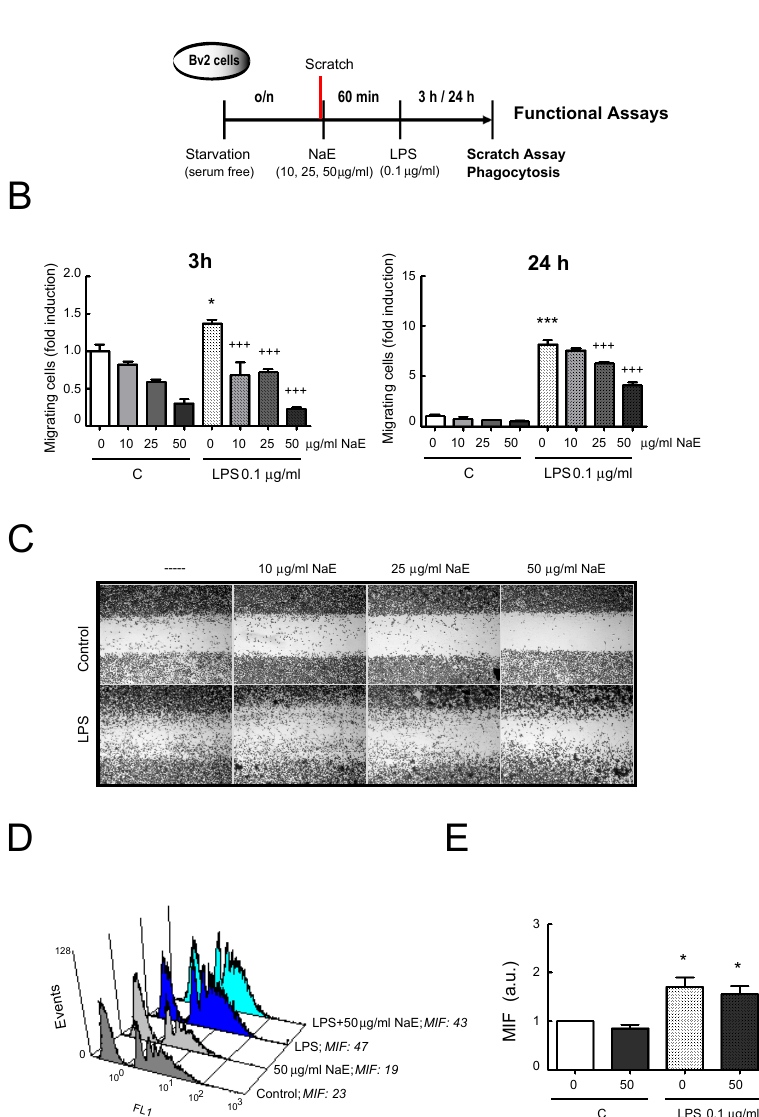
Figure 6. Effect of NaE extract on BV2 microglia functions. ( A ) Experimental steps. BV2 cells were pre-treated with the indicated doses of the NaE extract for 1 h at 37 °C and then stimulated or not with 0.1 µ g/mL of LPS. ( B ) Migration assay: Data were reported as BV2 cell migration into the scratch area at 3 h and 24 h post-scratch. Values are means ± SD of the three independent experiments. *** p < 0.001 and * p < 0.05 vs. control; and +++ p < 0.001 vs. LPS-treated cells. ( C ) Representative images showing cell migration in the different conditions at 24h. Magnification, 40 × . ( D , E ) Phagocytosis assay using YG-microparticles and flow cytometry analysis. ( D ) Representative histogram. MFI: mean fluorescence intensity. ( E ) Graph represents fold change in mean fluorescence intensity (MFI) of YG-microparticles phagocytized calculated with respect to unstimulated controls cells. * p < 0.05 vs. control cells. N =